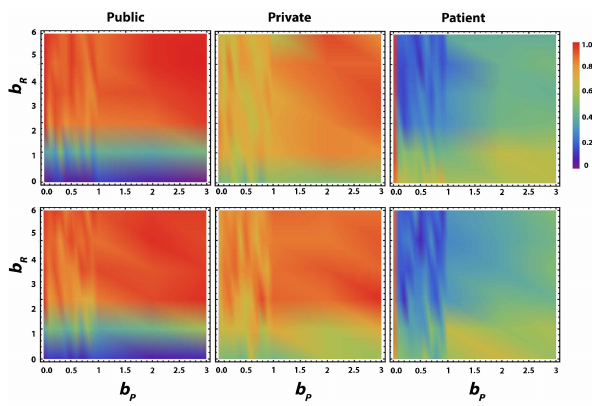
Figure 5. Cooperation levels in each population based on the ratio of hospital bed availability provided by healthcare providers compared to the size of the P3 population( N =100). Where the size of the P1 , P2 is: 3 first row N and second row N . 1 = N 2 = 10 1 = N 2 = 5 Other parameters as in Figure